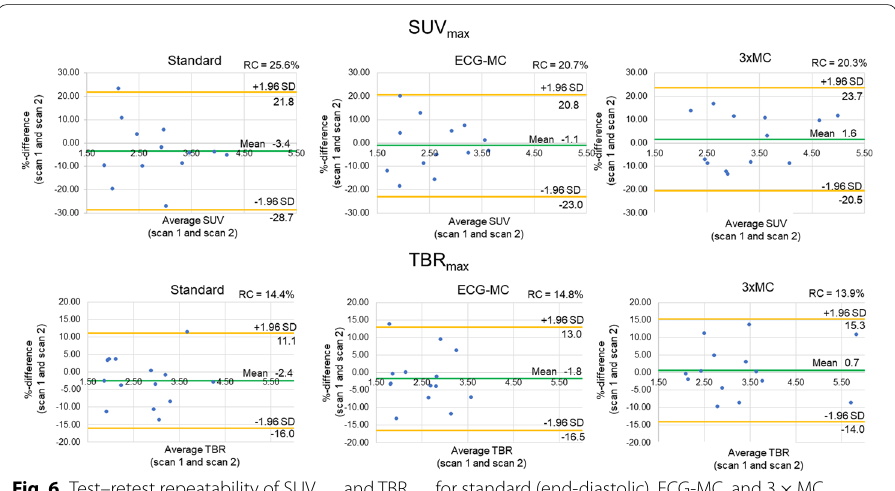
Fig. 6 Test–retest repeatability of SUV max and TBR max for standard (end-diastolic), ECG-MC, and 3 reconstruction protocols. RC repeatability coefficient, TBR max = ECG-MC cardiac contraction motion-corrected, 3 =